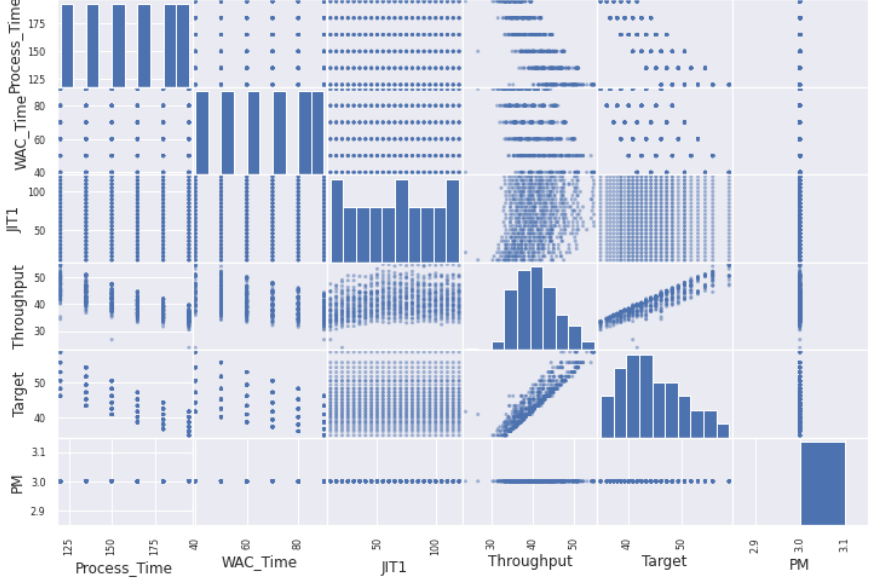
Figure 3. Correlation between throughput and process time, WAC time, and JIT1.